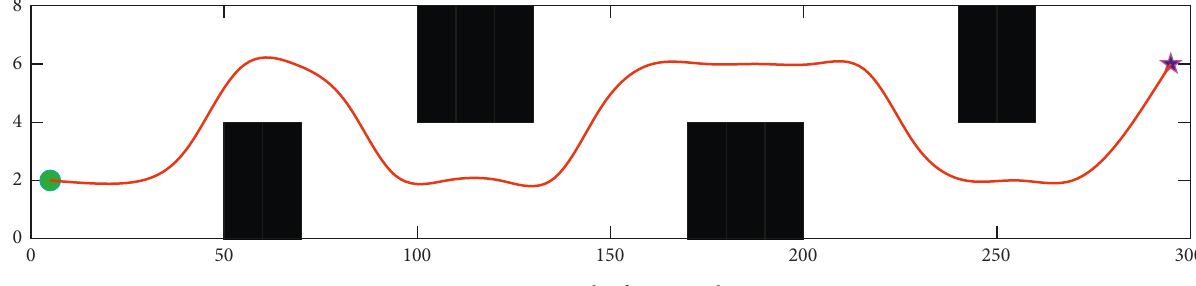
Figure 12: Path after